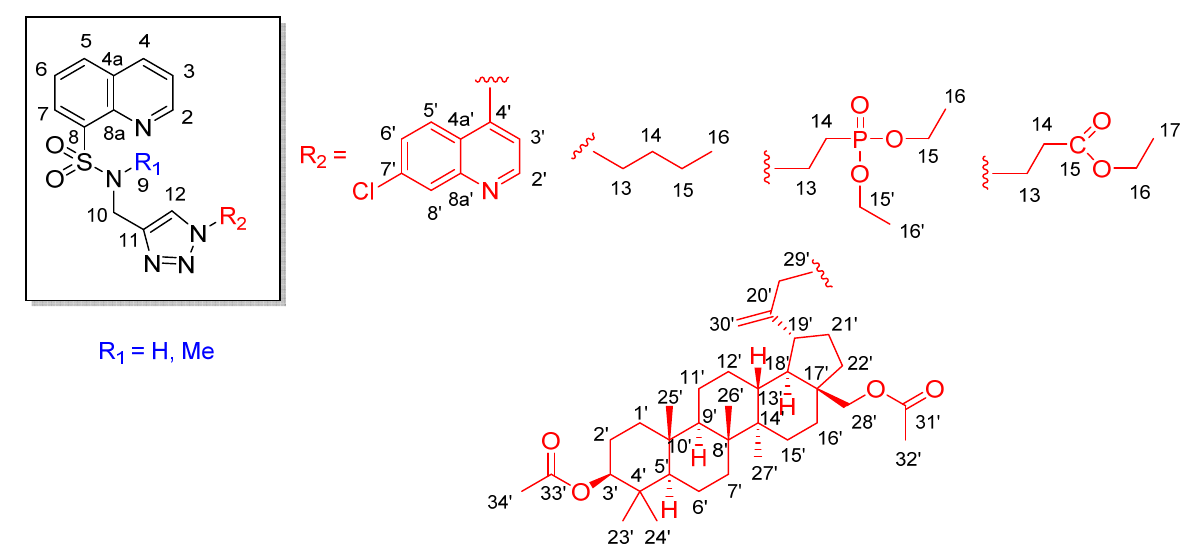
Figure 10. Compounds 9a – e numbering system used in the description of the NMR spectra.